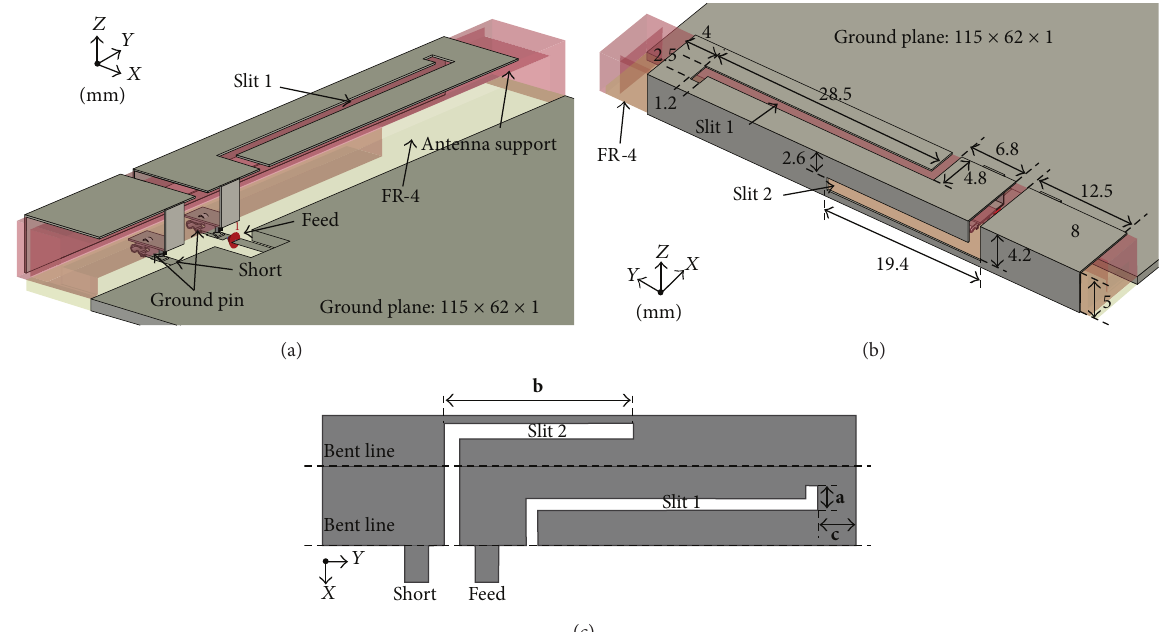
Figure 1: The geometry of the proposed penta-band PIFA: (a) overall view, (b) detailed dimensions, and (c) unfolded view of the radiating elements.